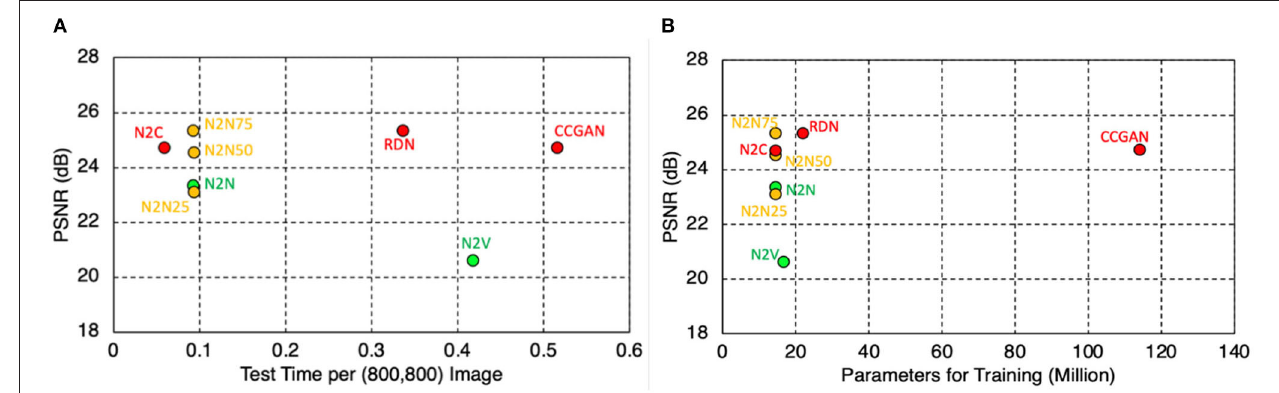
FIGURE 8 | Comparison of computational requirement for the different DL-based denoising algorithms on 2 Nvidia Quadro RTX 6000 GPU systems, in terms of (A) computation time per (800,800) image, and (B) memory requirements as represented by parameters required for training. Red, fully supervised DL denoising models; yellow, semi-supervised DL denoising models; green, un-supervised DL denoising